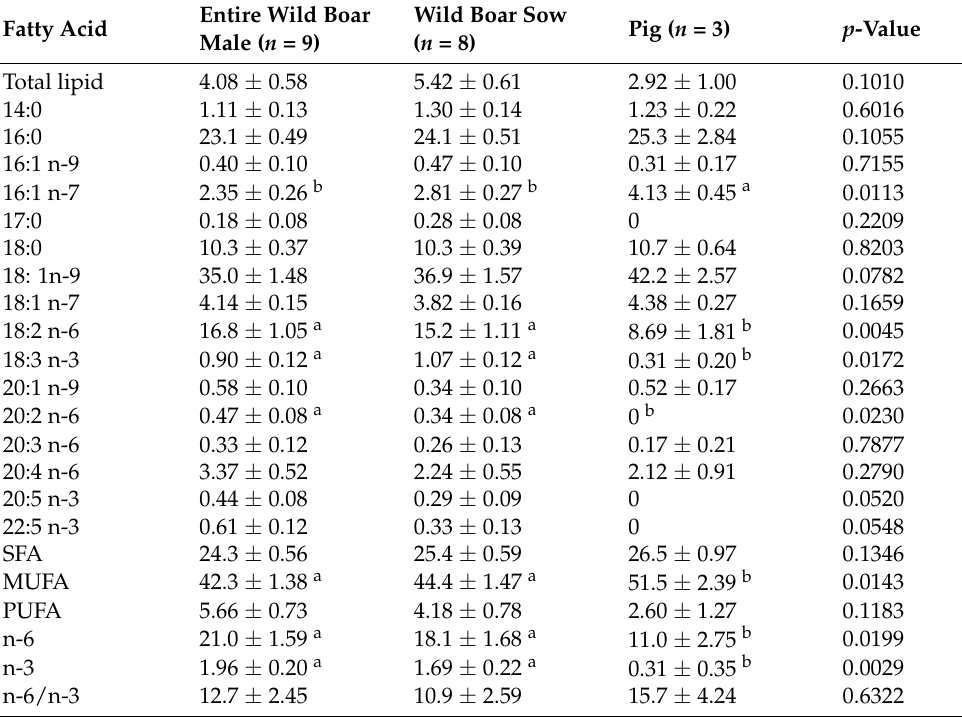
Table 2. Total lipid content (g/100 g tissue) and individual fatty acid content (g/100 g total identified FA) in meat from wild boar and pig. Data are given as means and standard